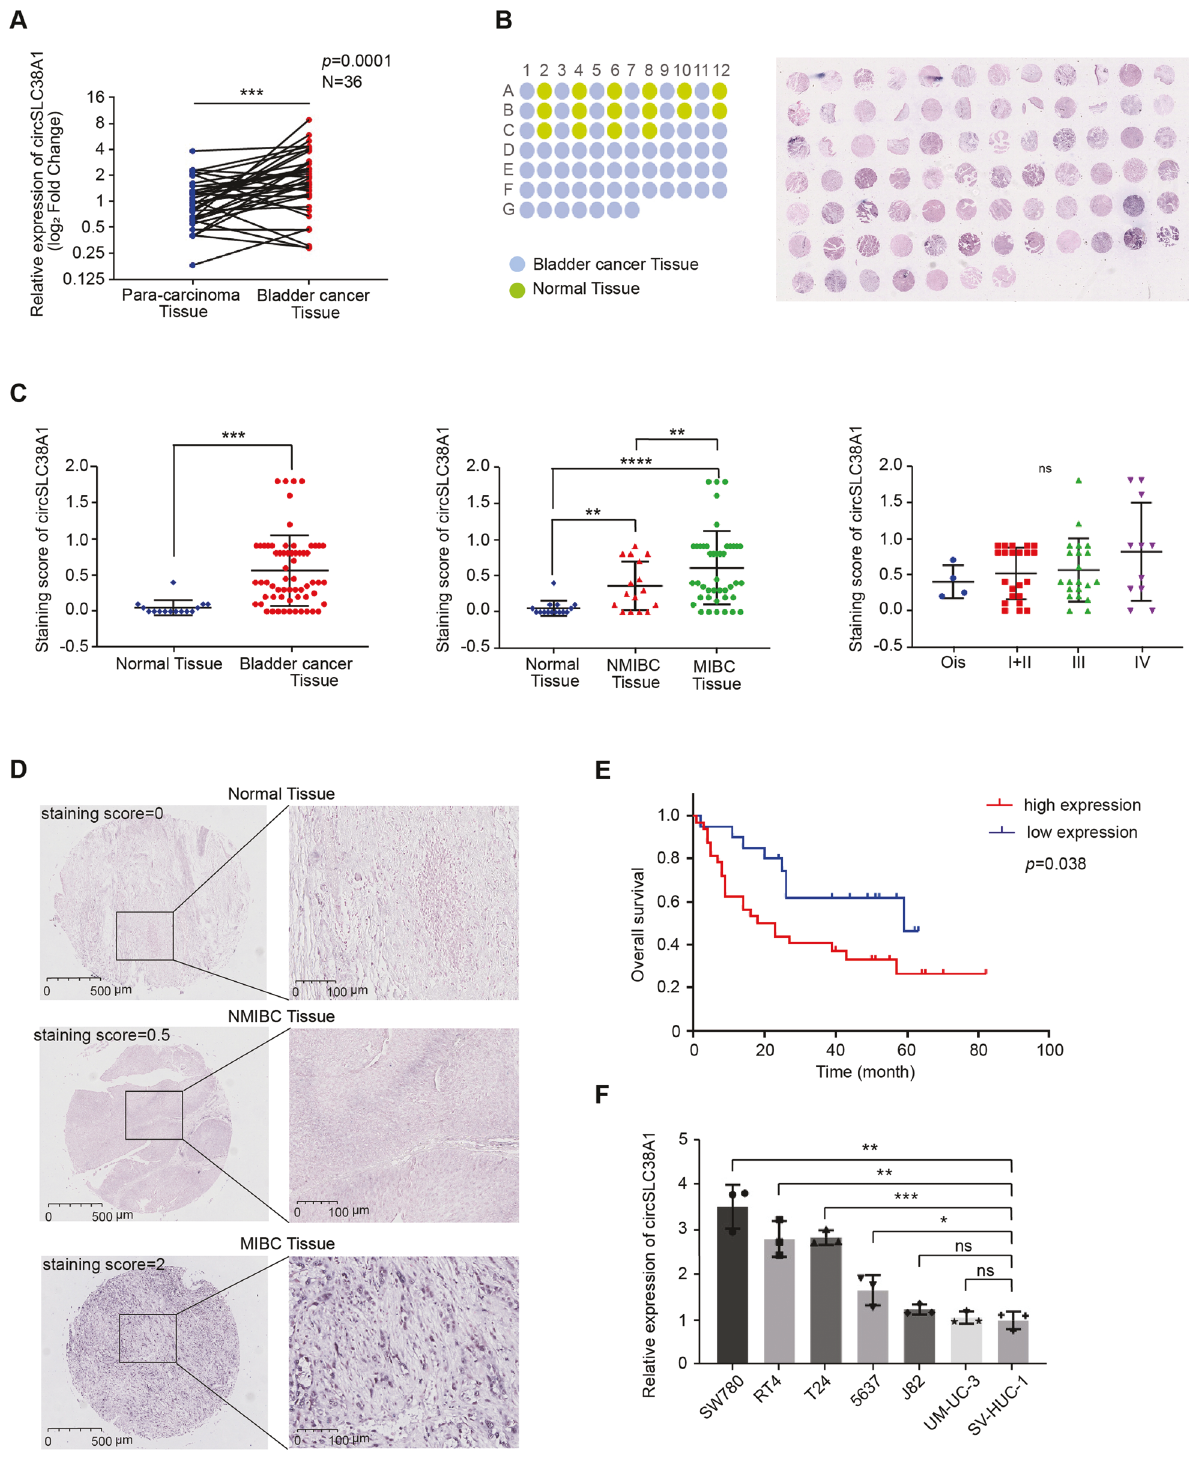
Fig. 2 circSLC38A1 is upregulated in BC. A Expression levels of circSLC38A1 in 36 pairs of BC and adjacent normal tissues were detected by the divergent primers ( P = 0.0001). B The expression level of circSLC38A1 was measured by RNA ISH staining tissue microarrays ( n = 79). C The difference in staining score between normal tissues and BC tissues (left), the difference in staining score between NMIBC tissues and MIBC tissues (middle), and the correlation of circSCL38A1 expression with tumor node metastasis classi fi cation (TNM) of bladder cancer (left). The staining score = staining intensity score * staining positive rate. (staining intensity score 0 is de fi ned as negative, staining intensity score 1 + is de fi ned as weak expression, staining intensity score 2 + is de fi ned as moderate expression, and staining intensity score 3 + is de fi ned as a strong expression). D The representative staining images were shown. E Kaplan – Meier analysis of the correlation between circSLC38A1 expression and overall survival. Patients with high levels of circSLC38A1 had signi fi cantly shorter overall survival ( P = 0.038). The P value was determined by a Log-rank test. F Relative expression of circSLC38A1 in BC cell lines and human normal urothelial cell line measured by qRT- PCR. Data are presented as means ± standard deviation from three independent experiments. * p < 0.05, ** p < 0.01, *** p < 0.001, **** p < 0.0001. Cell Death and Disease (2023)